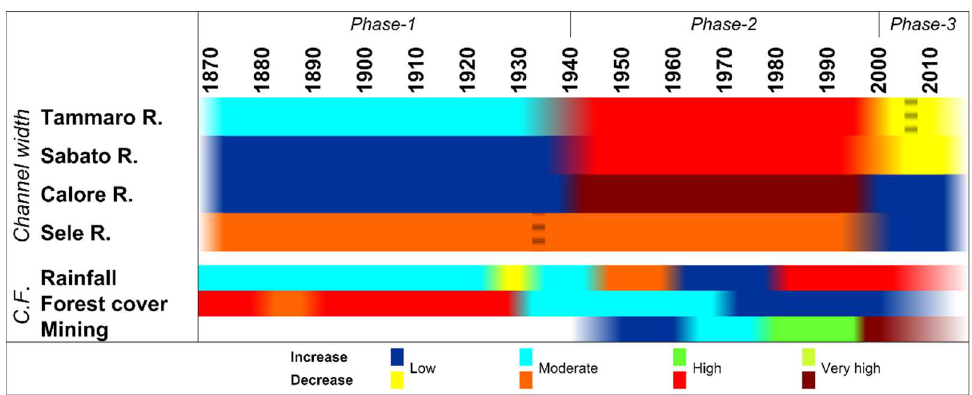
Figure 7. Channel mean width (CMW) evolutionary trajectories of the investigated rivers and controlling factors in the considered period. Shaded cells indicate years of damming along the Tammaro and Sele Rivers. C.F.: controlling factors. Rainfall data are from [18,22,23]; forest cover data are from [32]; mining data are from [2] and [7].